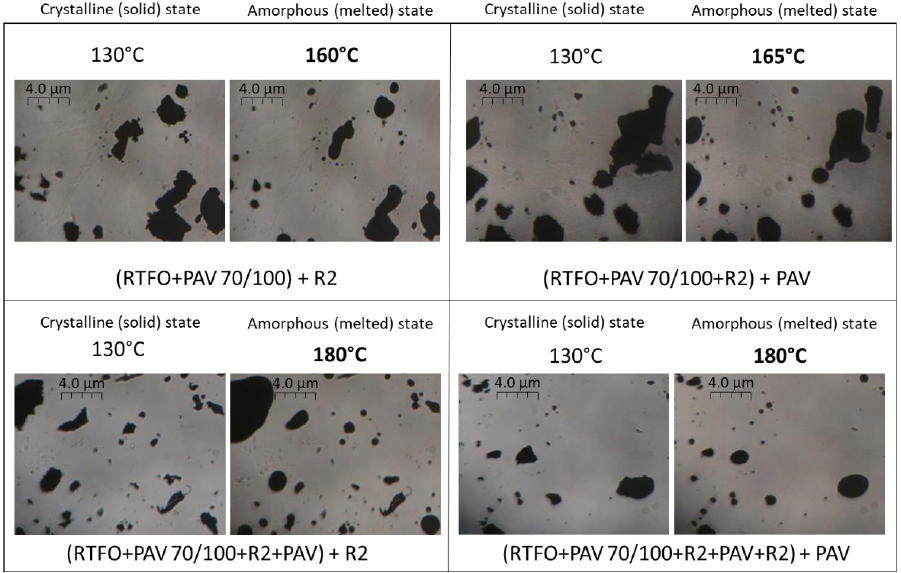
Figure 7. Light microscopy images indicating asphaltene melting points of R2-modified and aged 70/100 bitumen.